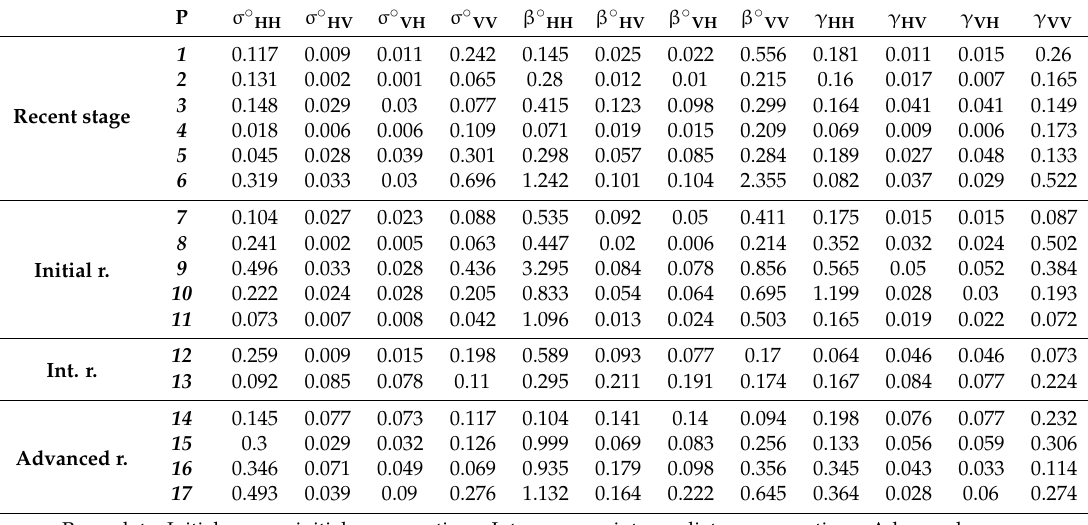
Table 2. Mean backscattering values in σ ˝ , β ˝ and γ extracted for each plot (P). See Figure 3 for the location of the